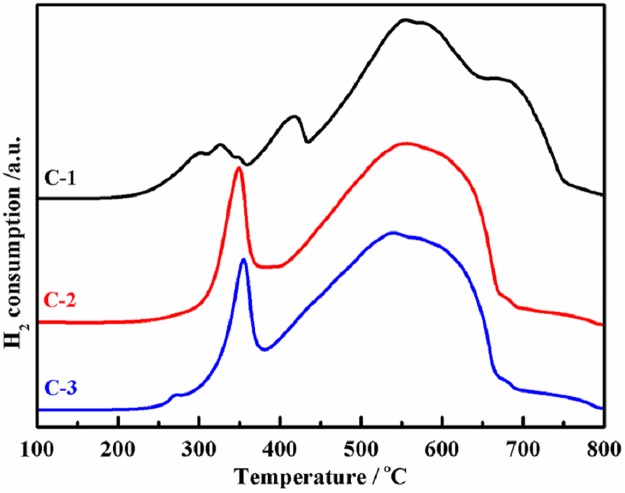
H2-TPR profiles of the catalysts.